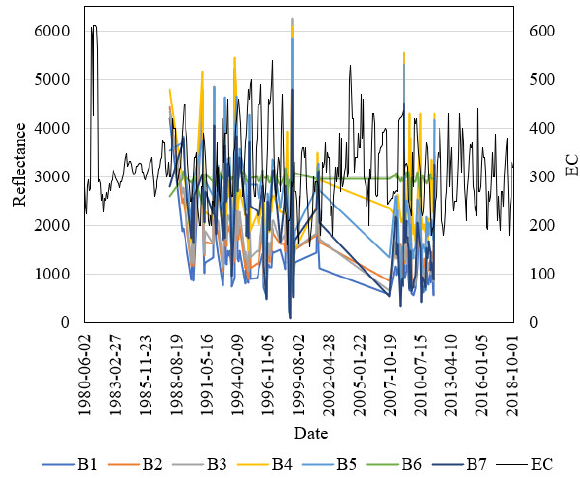
Figure 2. Spectral reflectance of Landsat 5 bands and ground measured EC for Paliakalan station, India